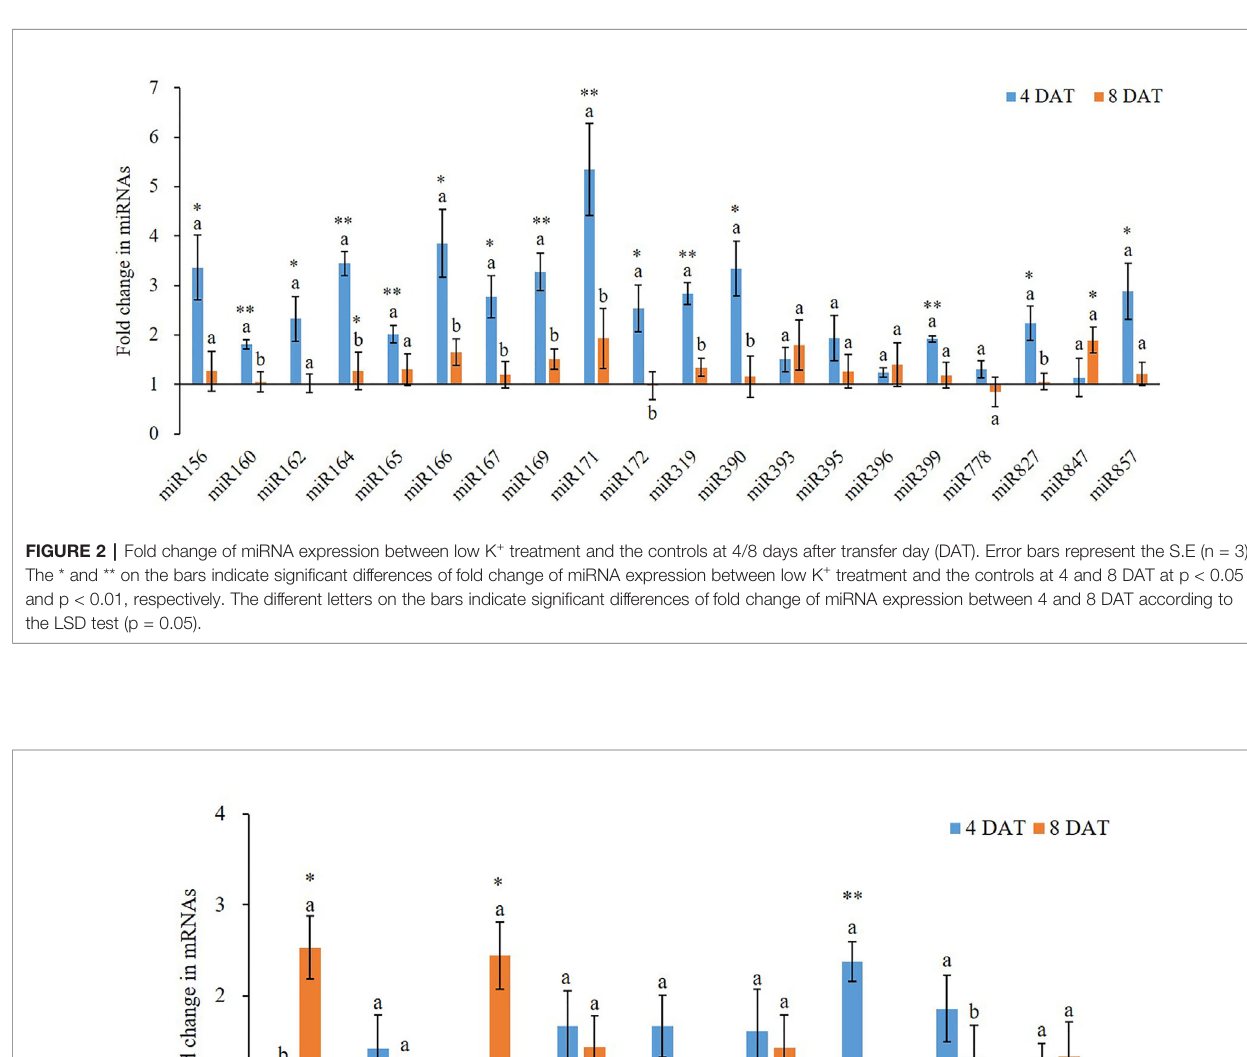
*Different lower-case letters indicate signi fi cant difference at P < 0.05 level.